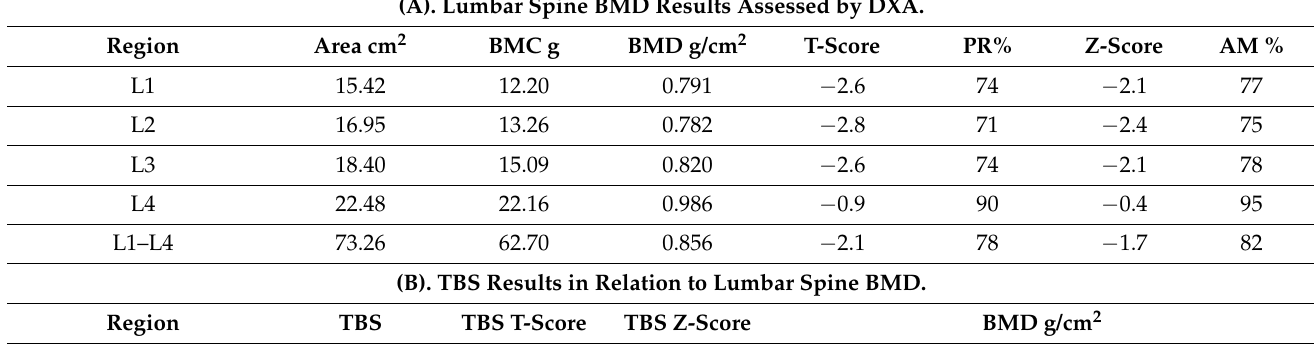
Table 2. Lumbar spine bone density (DXA), TBS results and BMD